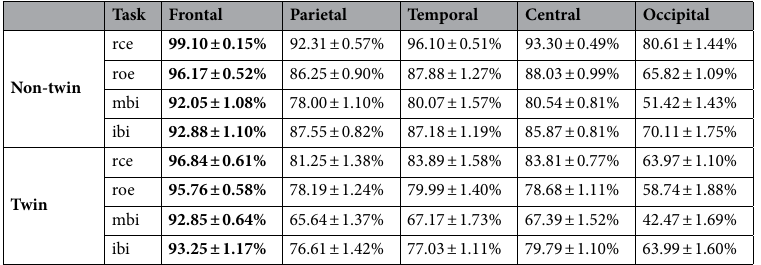
Table 1. Spatial differences in base signals. Each cell in the table shows the mean accuracy and its standard error of 10-person identification using EEG data from a particular task (row) and brain region (column). rce = resting with closed eyes, roe = resting with opened eyes, mbi = moving both fists, ibi = imagining moving both fists. For each task, the best region-based identification results are highlighted in